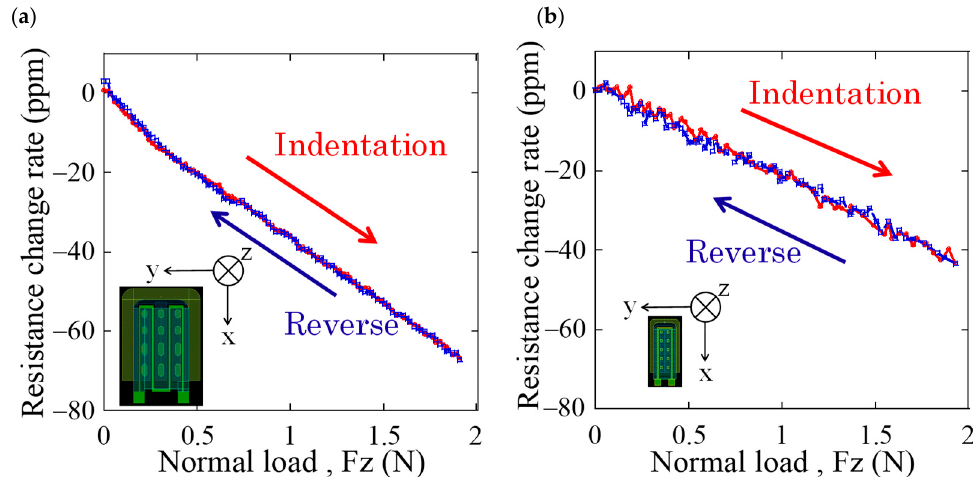
Figure 8. Response characteristic for normal load of ( a ) conventional cantilever, and ( b ) newly fabricated cantilever.